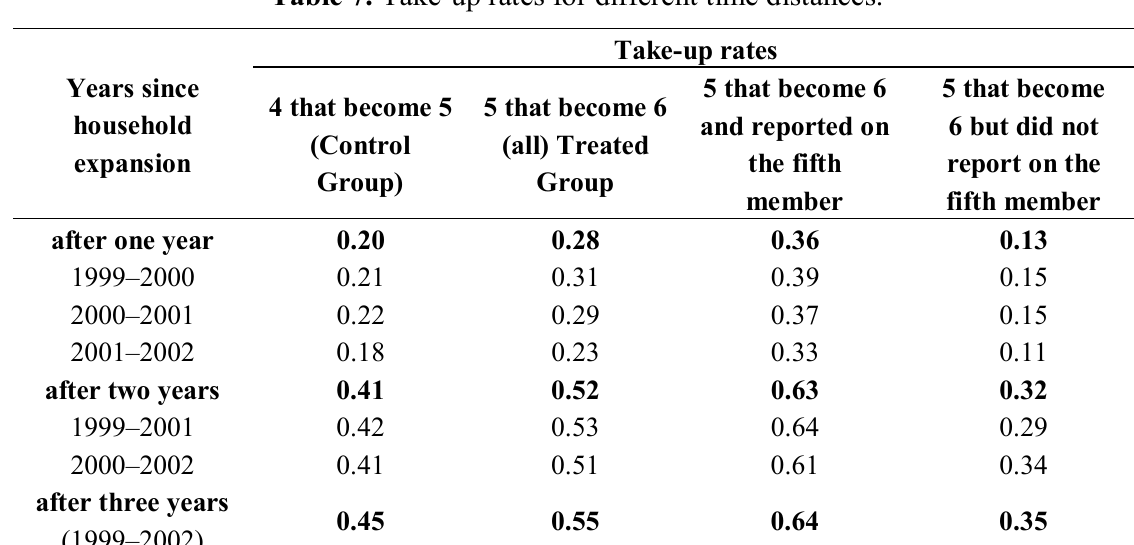
Table 7. Take-up rates for different time